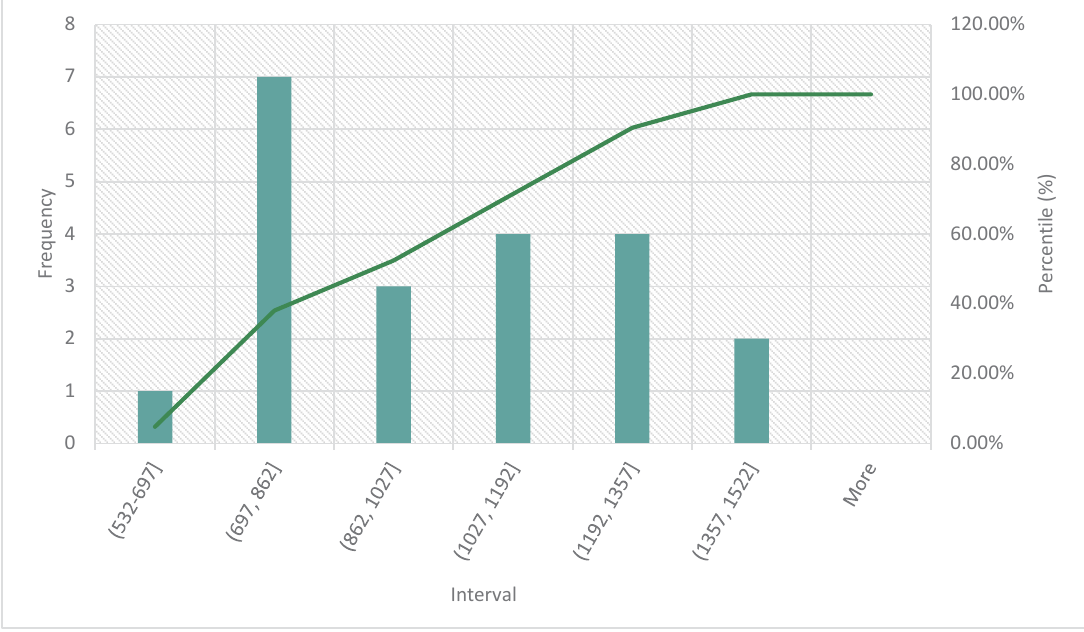
Fig. 1: Histogram and Pareto Graphic for TN Osceola County